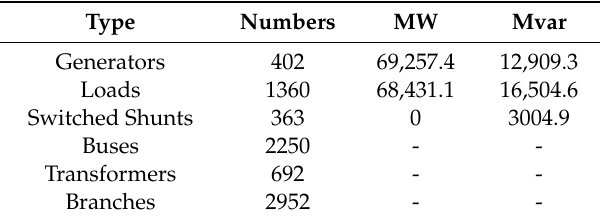
Table 1. Korean electric power system information used in the